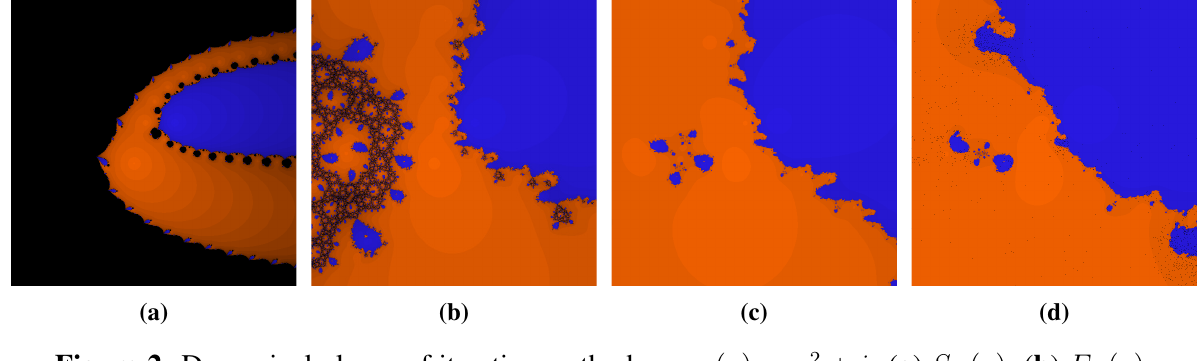
Figure 2. Dynamical planes of iterative methods on p